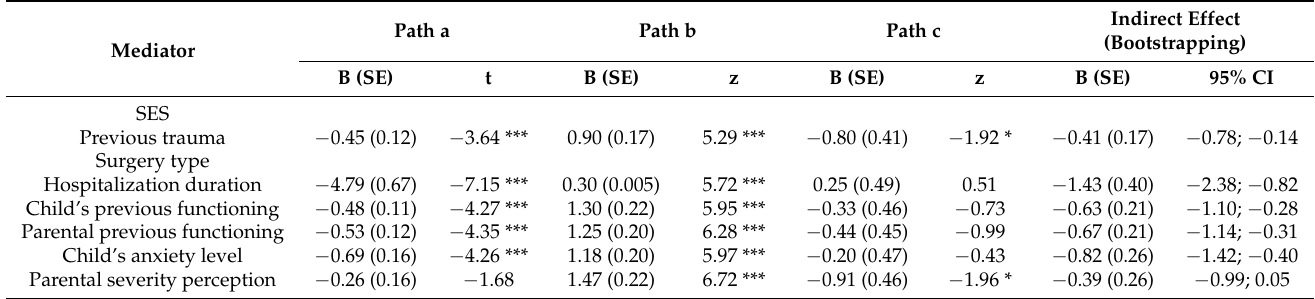
Table 4. Mediation models for the relationship between ethnic group and